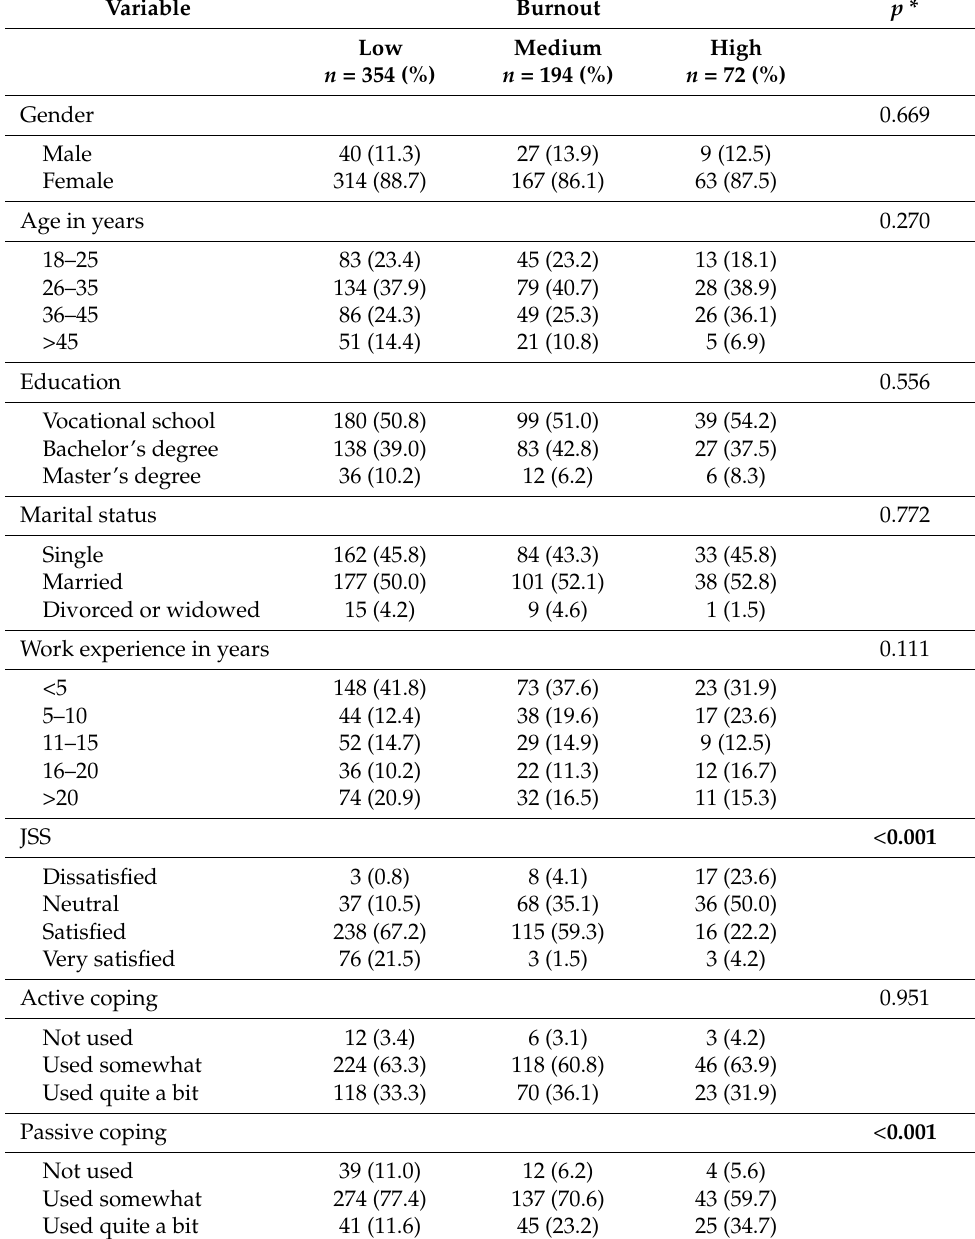
Table 2. Burnout (MBI TOT ) according to demographic characteristics, job satisfaction and